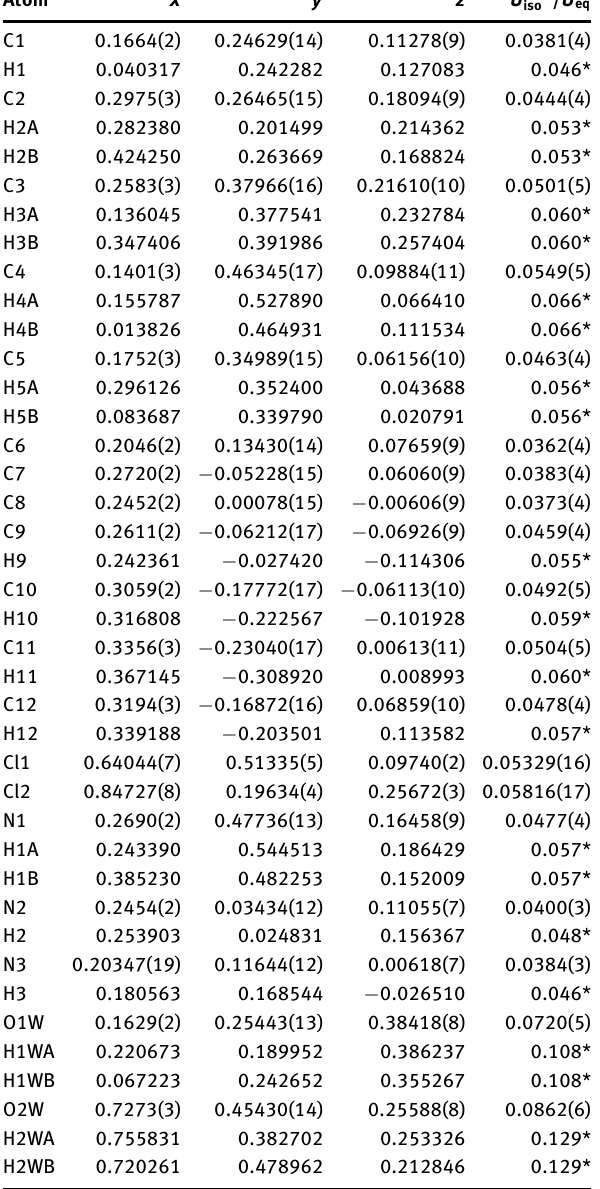
Table 2: Fractional atomic coordinates and isotropic or equivalent isotropic displacement parameters (Å 2 ).